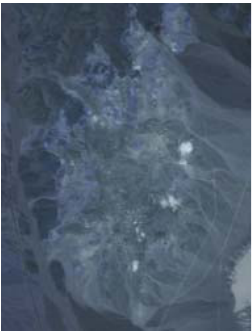
Figure 9. False-color image of the AVIRIS Cuprite